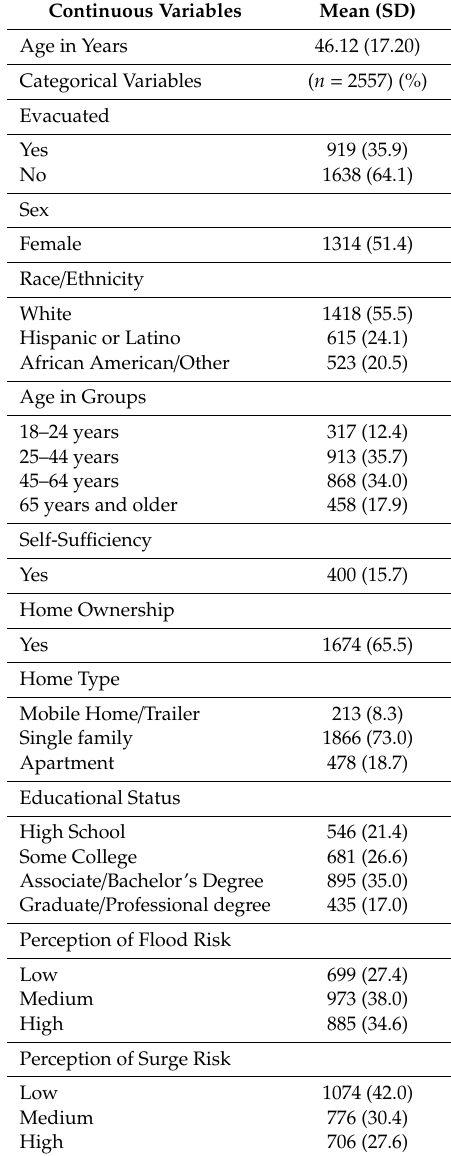
Table 1. Descriptive Statistics of Select Variables for Study